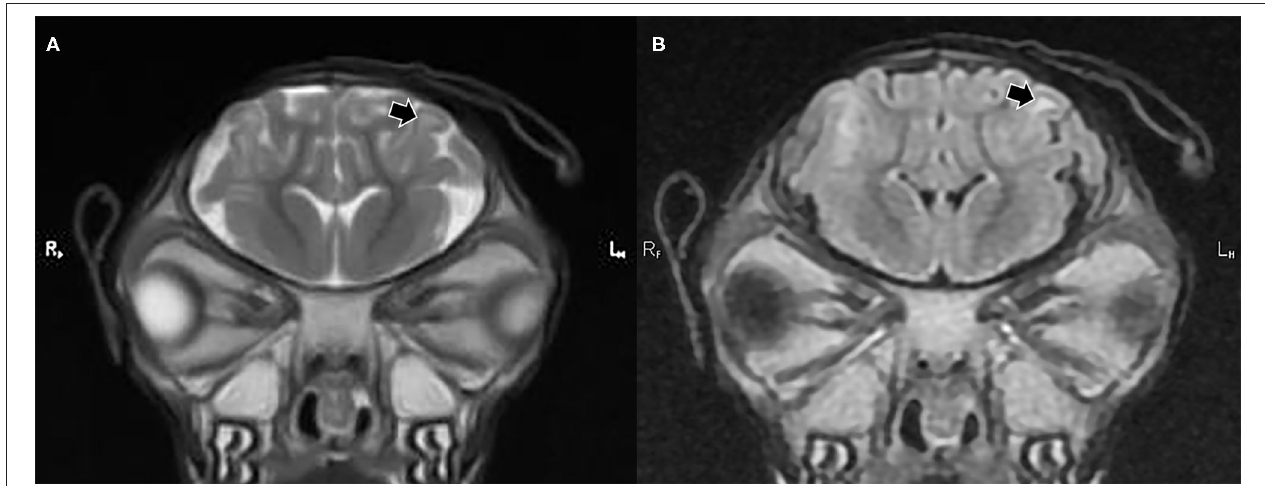
FIGURE 2 | T2 weighted (A) and fluid attenuated inversion recovery [FLAIR] transverse plane (B) images exhibiting focal cerebral abnormalities subjacent to the left horn bud that received iron application time of 5s. The black arrows highlight gyral edema evidenced by a hyperintense (whiter) region in the white matter of the gyrus, which remains hyperintense in the FLAIR